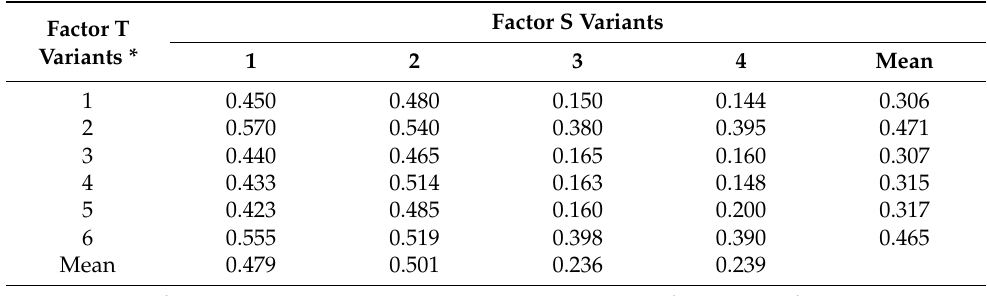
Table 6. Soil respiration intensity (CO 2 µ L m − 2 h − 1 ), depending on tillage method (factor T) and stubble management (factor S) applied in spring wheat